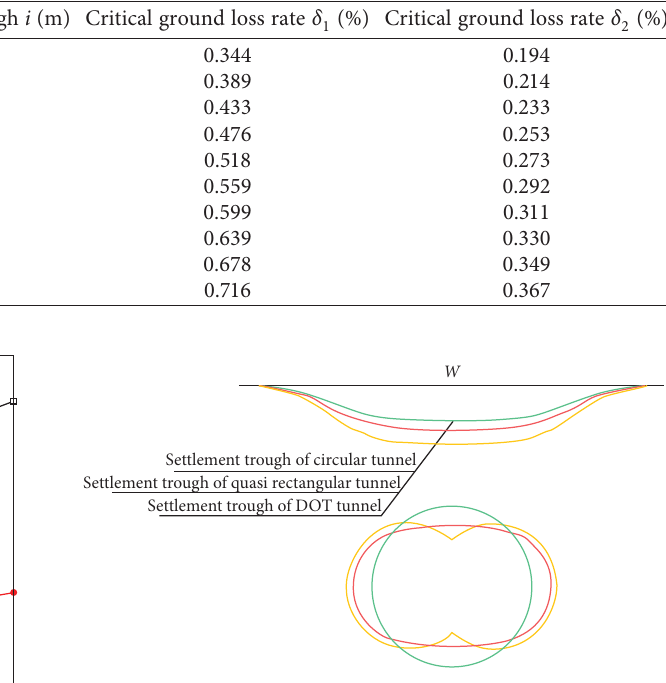
Figure 15: The rough sketch of surface settlement induced by circular, DOT, and quasi-rectangular shield construction.